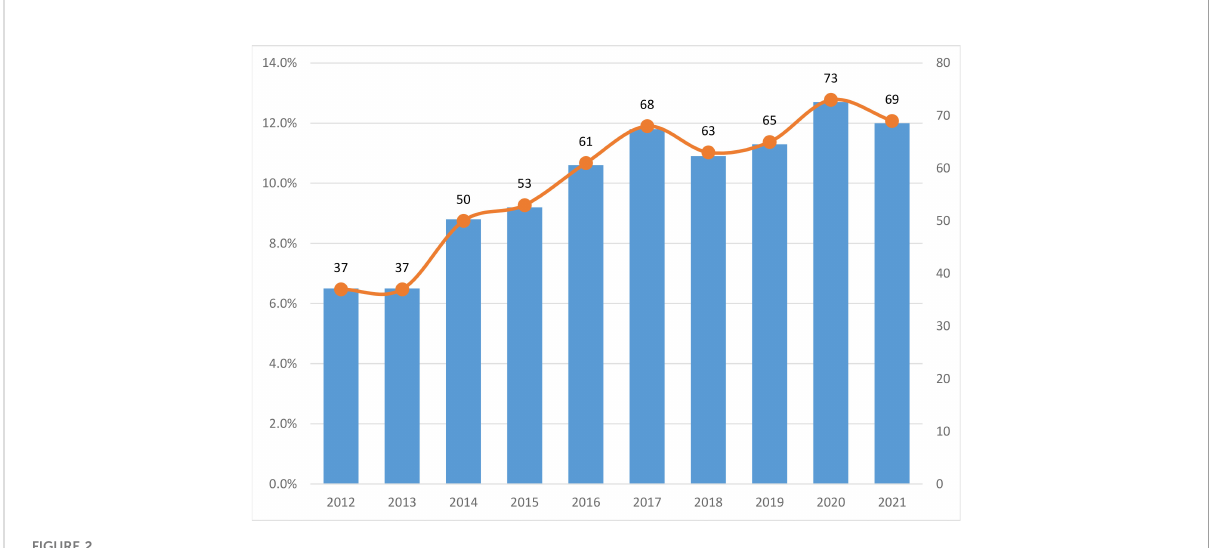
FIGURE 2 Number of the publications from 2012 to